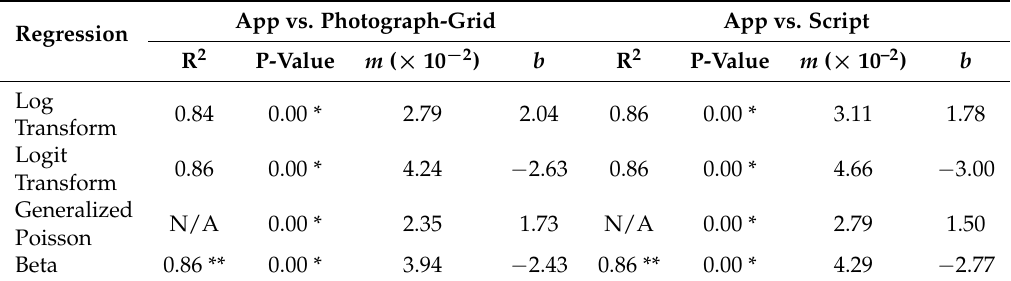
Figure 6. Relationships between residue cover percent as determined by script and app with 95% CI: ( a ) OLS log-linear regression; ( b ) OLS logit-linear regression; ( c ) generalized Poisson regression; ( d ) Beta regression with logit link. Table 4. Summary statistics of non-linear regression models between residue cover percent as determined by photograph-grid and script versus app